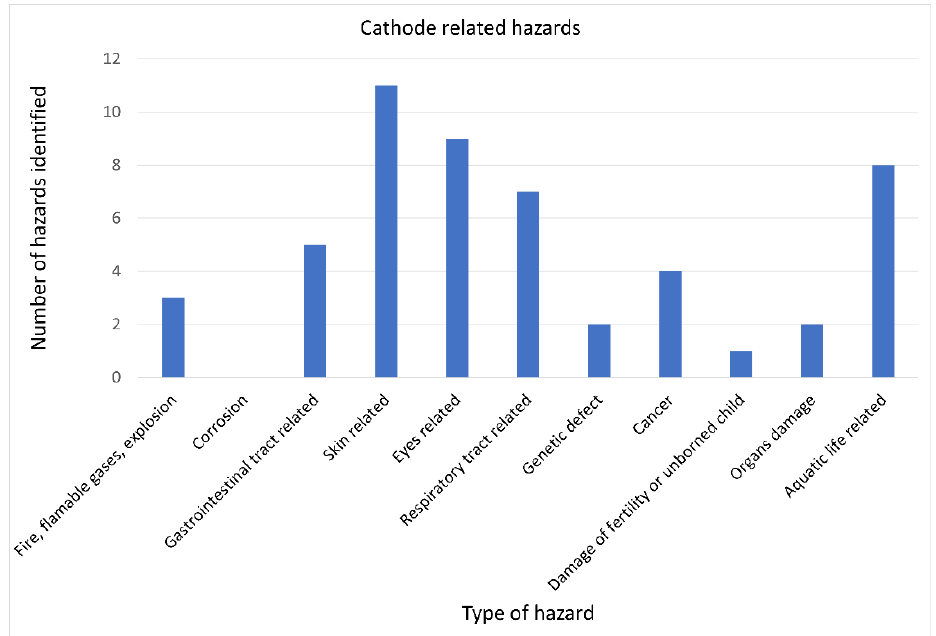
Figure 8. The number of the hazards identified versus the type of hazard for cathode materials in Mg–S cells.